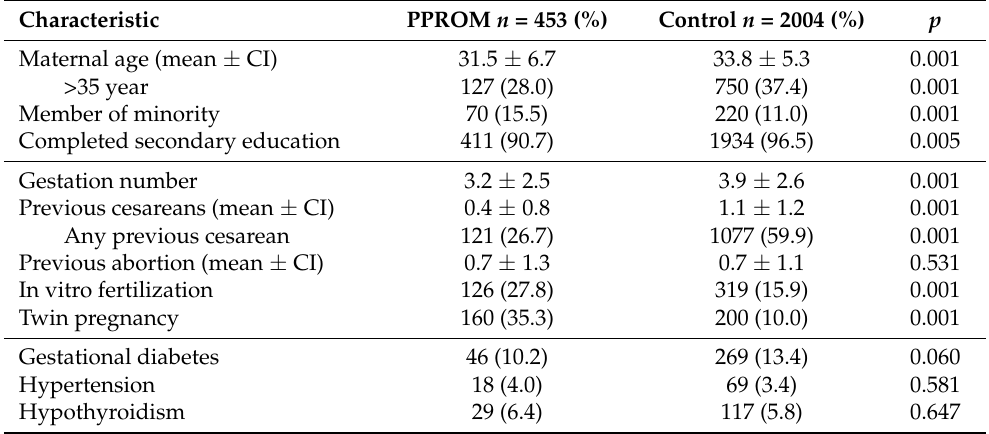
Table 1. Demographic, obstetric and medical characteristics of study group versus control group. PPROM: preterm premature rupture of membranes; CI: confidence interval.